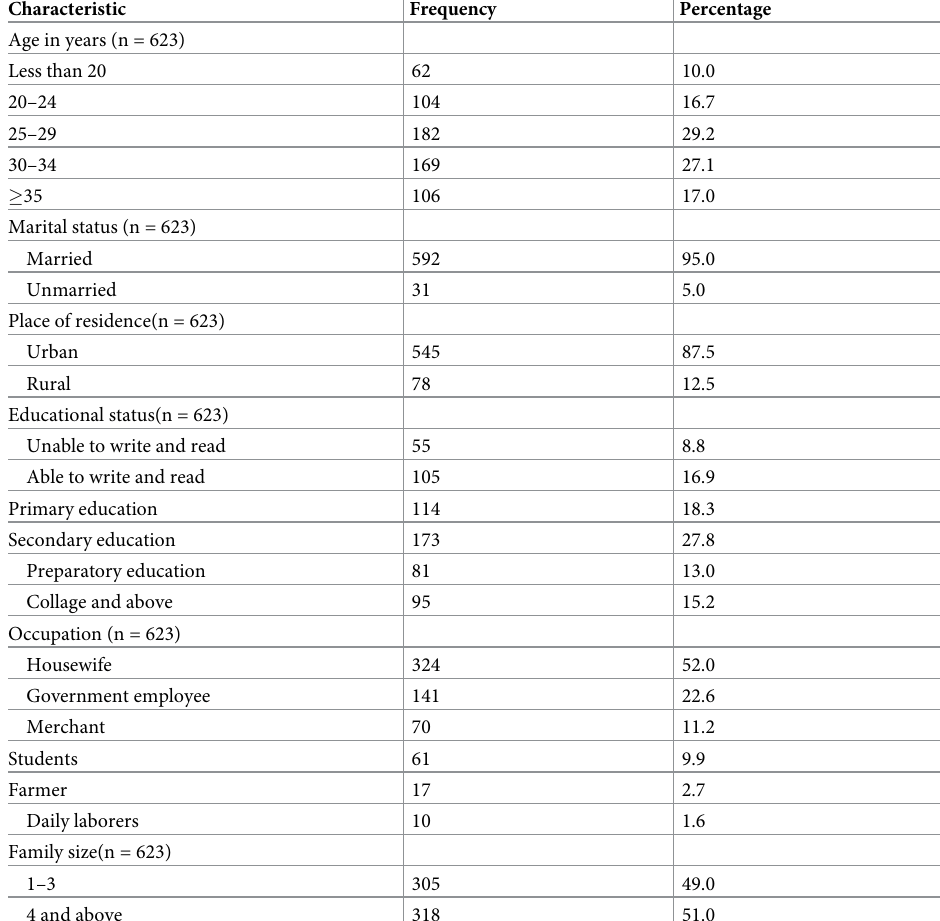
Table 1. Socio-demographic characteristics of ANC attending pregnant mothers in governmental health institu- tions of Adwa town, Northern Ethiopia, 2018.